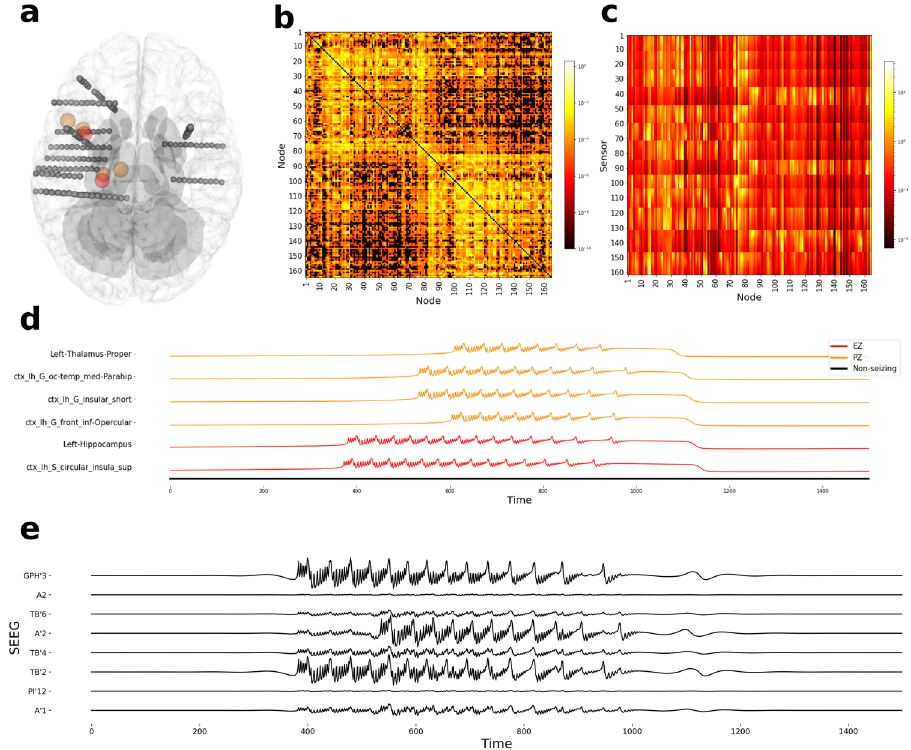
Fig. 9 Simulated seizure data generated using structural connectivity and electrode implantation of patient BT from the retrospective cohort. a Top view of electrode implantation. Spheres colored in red and orange represent the centers of regions in the EZ and PZ, respectively. b Structural connectivity in log scale. c Gain matrix, transformation matrix from source-to-sensor space, in log scale. d Simulated local fi eld potential ( x 1 ( t ) + x 2 ( t )) depicting the seizure propagation pattern. e Simulated SEEG activity from eight channels. EZ, epileptogenic zone; PZ, propagation zone; SEEG, stereotactic